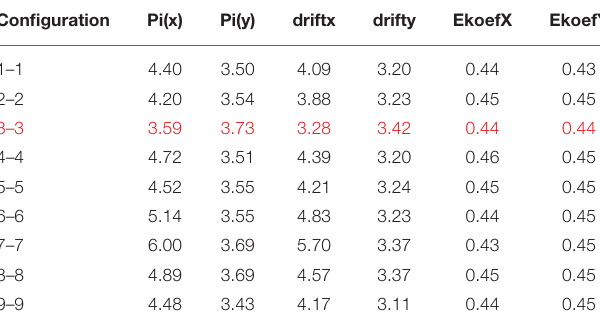
TABLE 8 | Configuration solutions for the fourth generation.